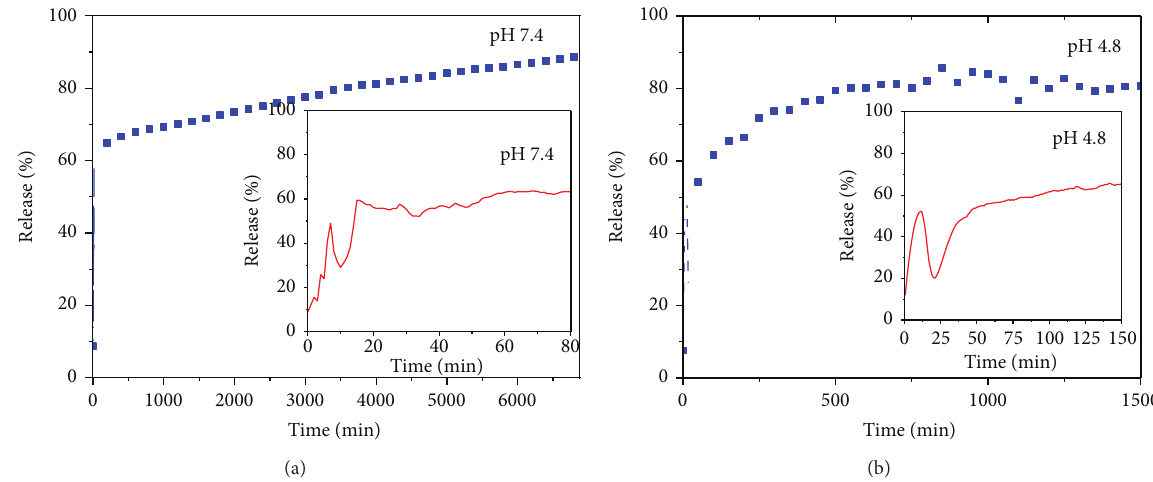
Figure 6: (a) In vitro release of PAS from PAS-ZLH (nanocomposite-A) in human body simulated phosphate buffer solutions of pH 7.4. (b) In vitro release of PAS from PAS-ZLH (nanocomposite A) in human body simulated phosphate buffer solutions of pH 4.8.